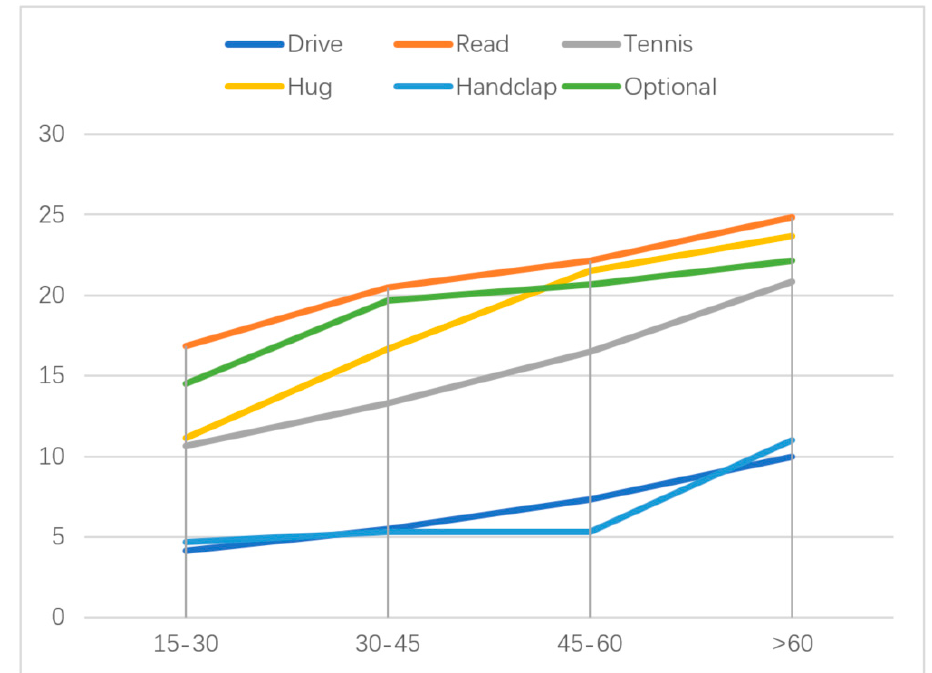
Figure 8. Mean action recognition time of each age group.